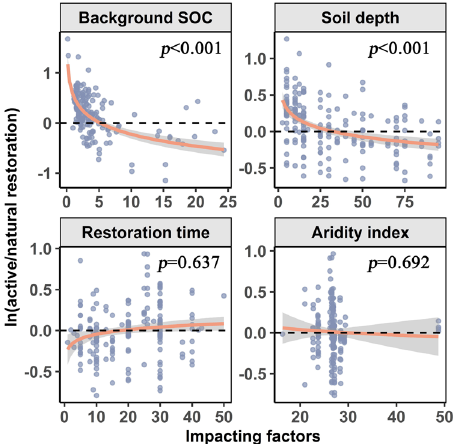
Fig. 4 The difference of carbon sequestration between active shrubland and natural grassland restoration along with background SOC, soil depth, restoration time, and aridity index across China. If the difference {ln (active/natural)} is >0, it represents a greater carbon sequestration by active shrubland than natural grassland restoration, or vice versa.